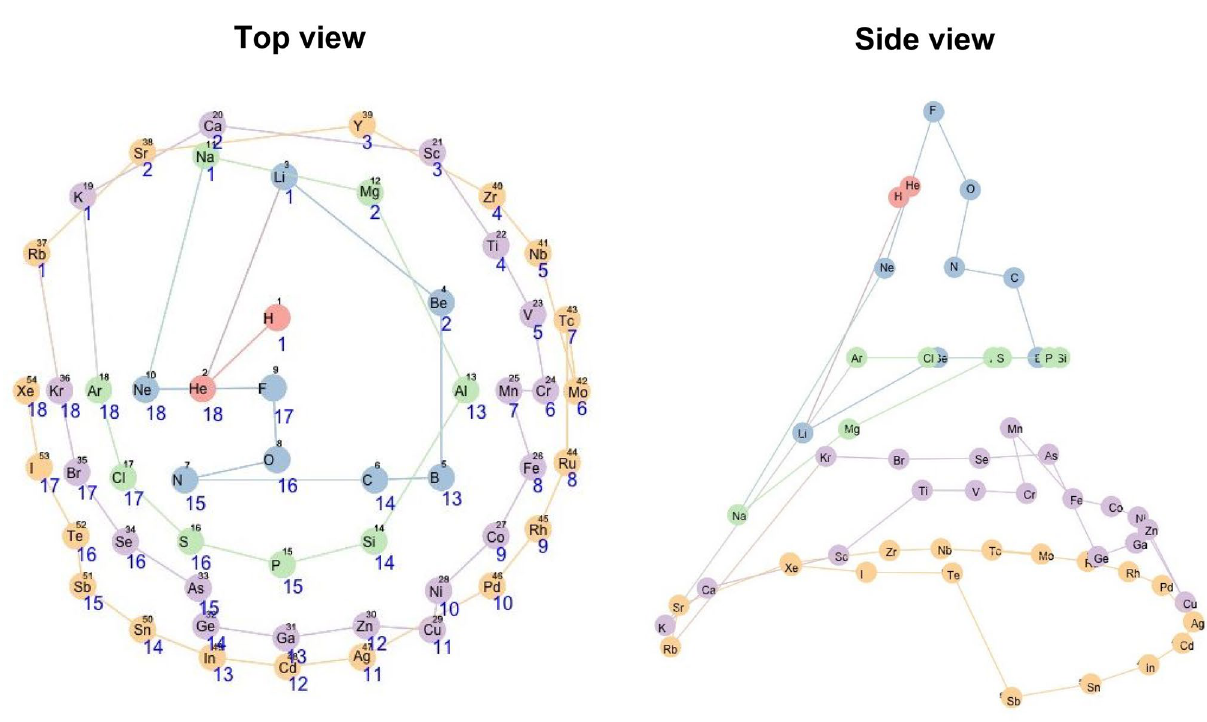
Figure 3. Created conical table of 54 chemical elements. The elements are colour-coded according to five periods and numbered by atomic numbers. A line passing through the elements is drawn in the order of atomic numbers. The number shown in blue below each element symbol represents the group number (the column in the standard periodic table). The left and right figures show the same table viewed from top and side,